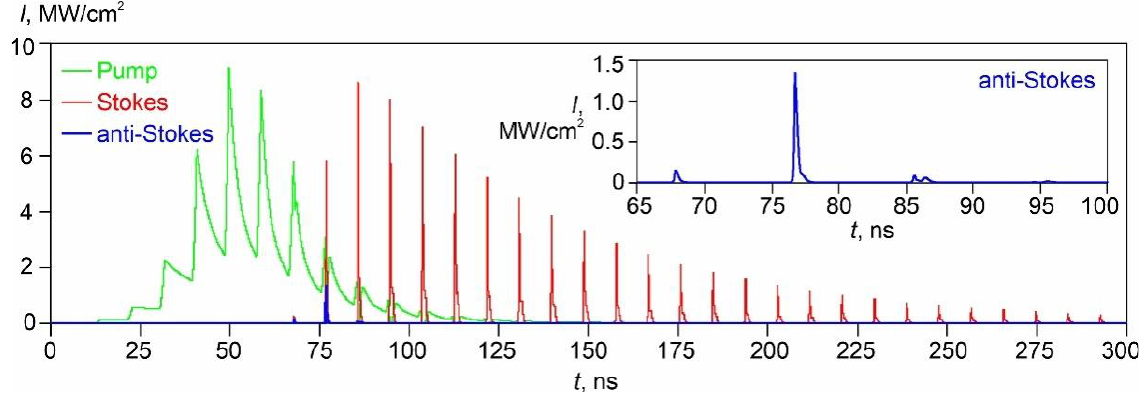
Figure 7. The simulation result of the passively Q-switched laser oscillation for the shutter with T Q 0 = 40% and T Q 1 = 85% at φ opt = 27°.